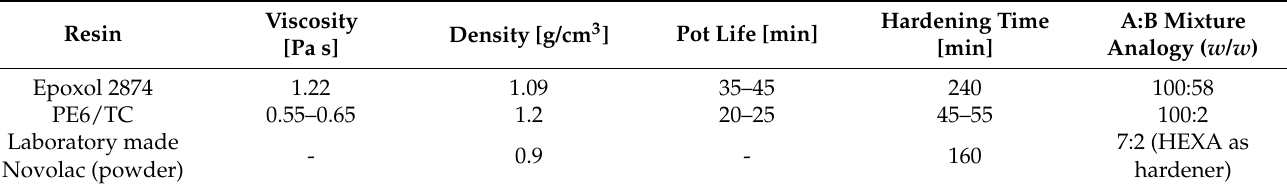
Table 1. Epoxy and unsaturated polyester resins technical specifications.